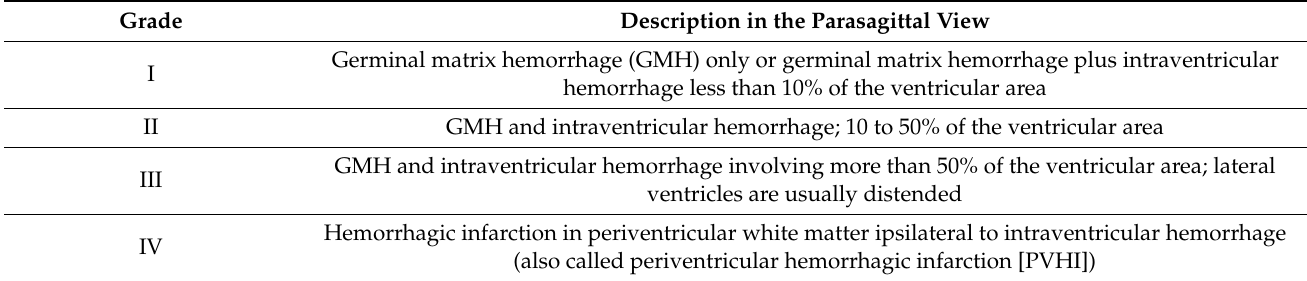
Table 1. Germinal matrix hemorrhage and intraventricular hemorrhage (GMH-IVH) grading system by Papile et al. [22]. Grade Description in the Parasagittal